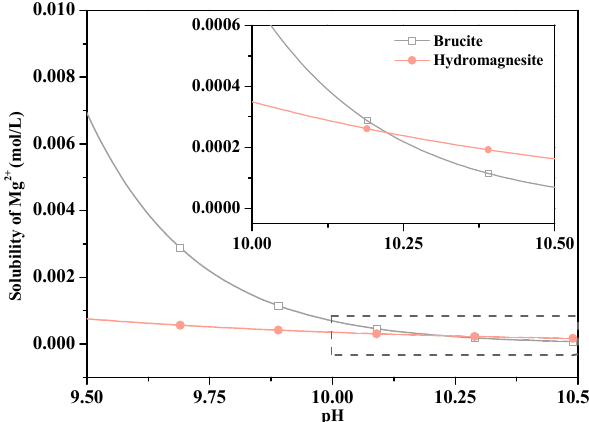
Figure 14. Relationship between the Mg 2 + solubility and pH in brucite and hydromagnesite (the K sp values of brucite and hydromagnesite are − 11.16 and − 38.47, respectively [40,41]).